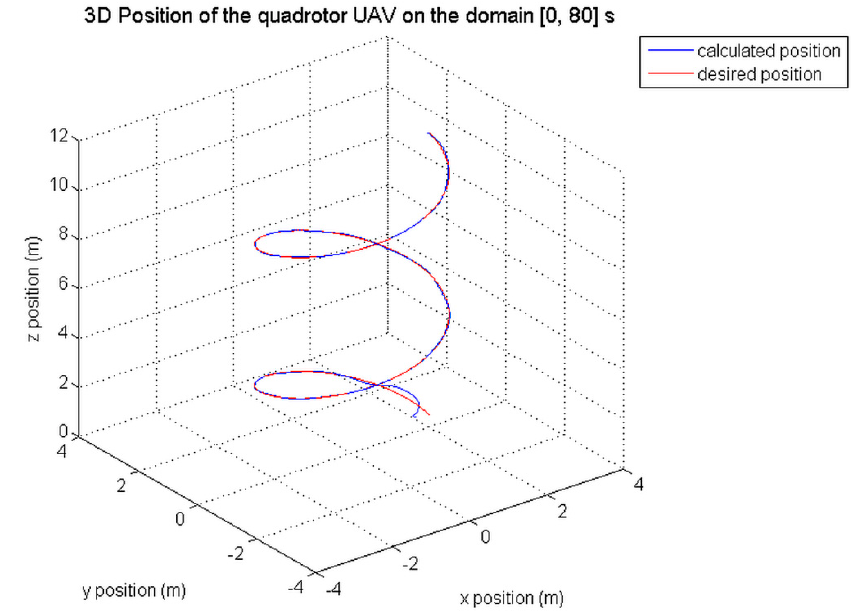
Figure 24. The 3D position of the quadrotor UAV obtained by the CMTC in the time interval [0, 80] s.